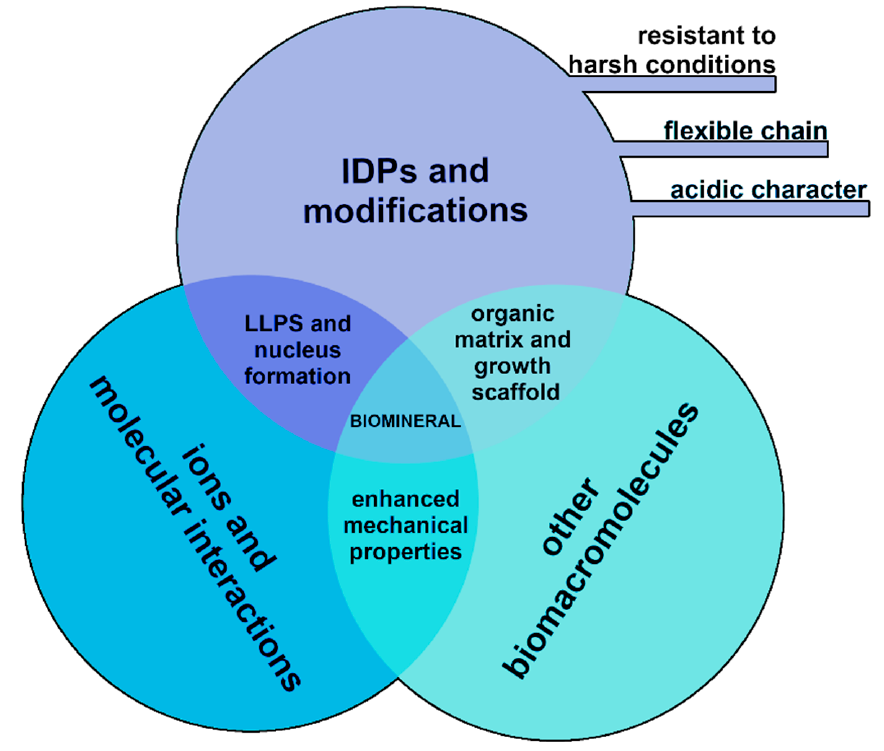
Figure 1. A conceptual diagram of the biomineral formation constituents and the relationships between them.